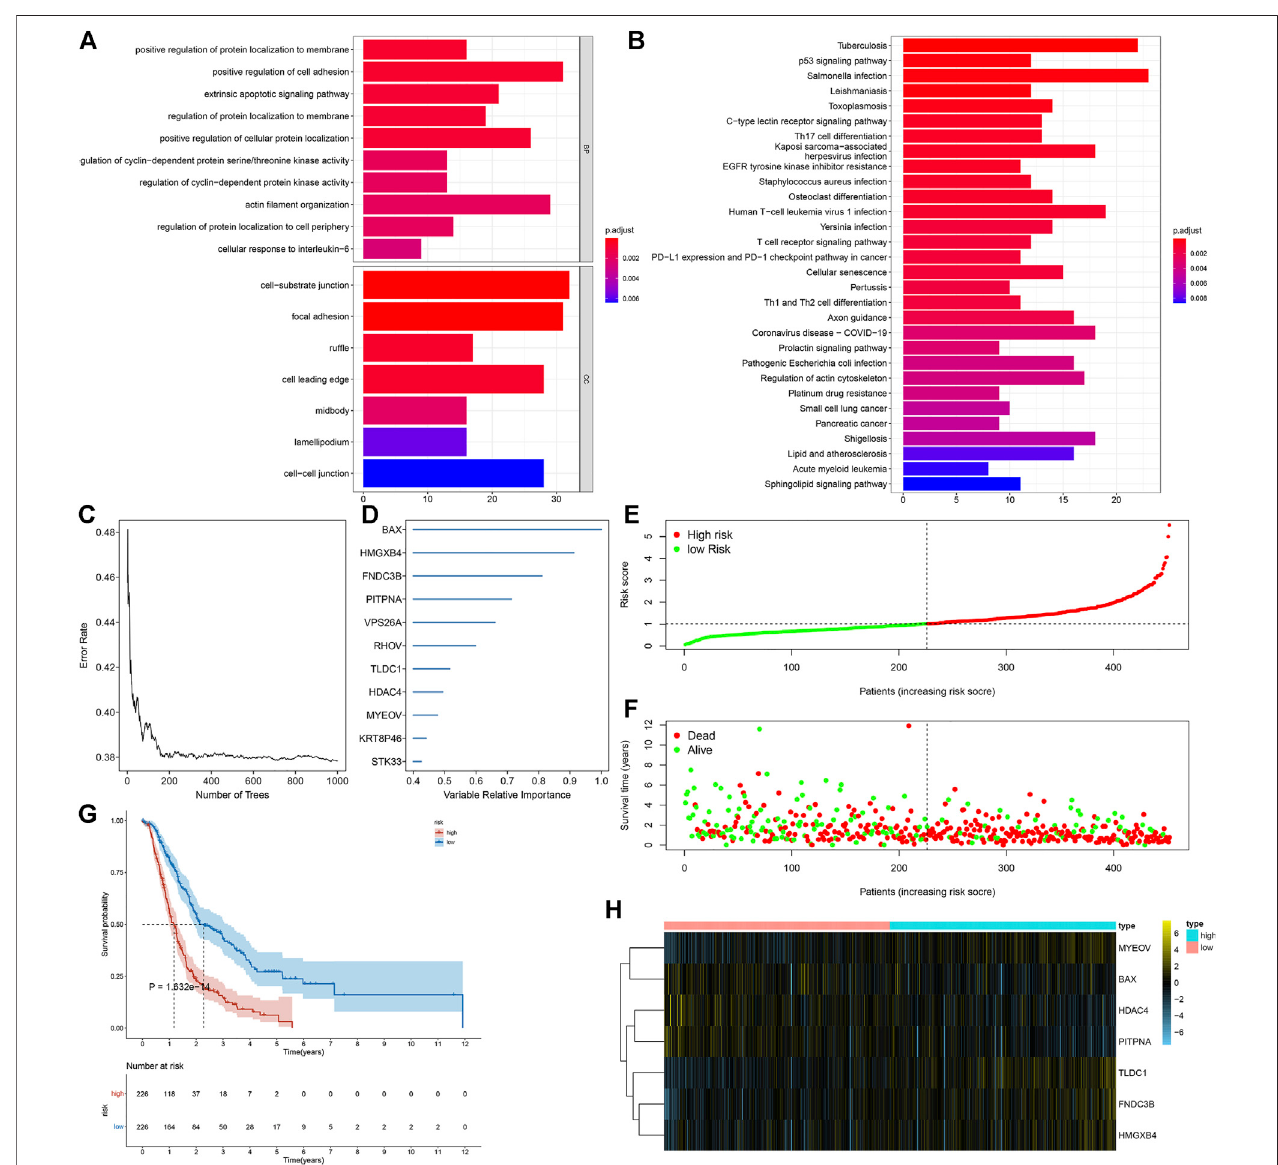
FIGURE 4 | Generation of a necroptosis-relevant risk model for pancreatic cancer prognosis. (A,B) GO and KEGG enrichment results of necroptosis-relevant genes. (C,D) Mostimportantnecroptosis-relevantgenesorderedbytherelativeimportancethroughtherandomforestapproach. (E,F) Distributionoftheriskscoreand survival status in high- and low-risk groups. (G) Survival analysis of high- and low-risk groups. (H) Heatmap depicts the expression of genes in the necroptosis-relevant risk model between two groups.